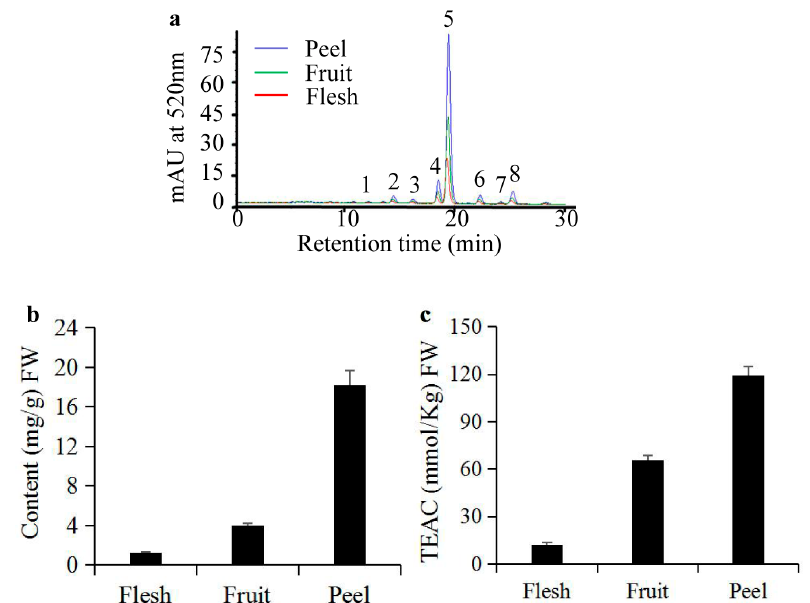
Figure 1. Different characteristics of anthocyanins from S. nigrum fruits. ( a ) HPLC chromatograms of anthocyanins in the peel, flesh, and the whole fresh fruit of S. nigrum ; ( b ) Anthocyanin content; and ( c ) total antioxidant activities in the peel, flesh, and the whole fresh fruit of S. nigrum .